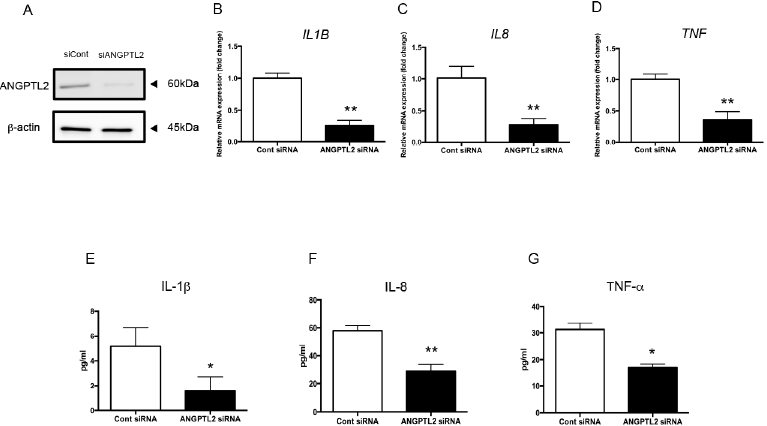
Fig 5. ANGPTL2 siRNA downregulates the inflammatory cytokine response to P . gingivalis LPS. (A) ANGPTL2 protein levels in Ca9-22cells transfected with ANGPTL2 or control siRNA. (B–D) Inflammatory cytokinemRNA levels in Ca9-22 cells transfected with ANGPTL2 or control siRNA after stimulationwith P . gingivalis LPS for 24 h. (E–G) Inflammatory cytokine protein levels in Ca9-22 cells transfected with ANGPTL2 or control siRNA after stimulationwith P . gingivalis LPS for 24 h. Differences amonggroups were analyzed using the Student’s t -test. Data are expressedas means ± SD ( n = 4). * p < 0.05, ** p < 0.01 vs. control siRNA.